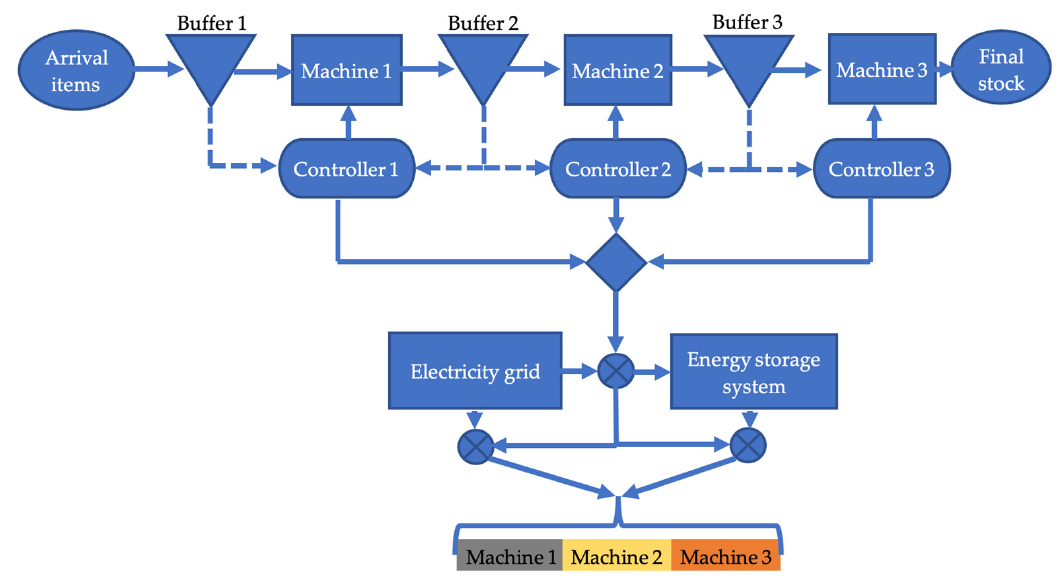
Figure 2. Simulation architecture.